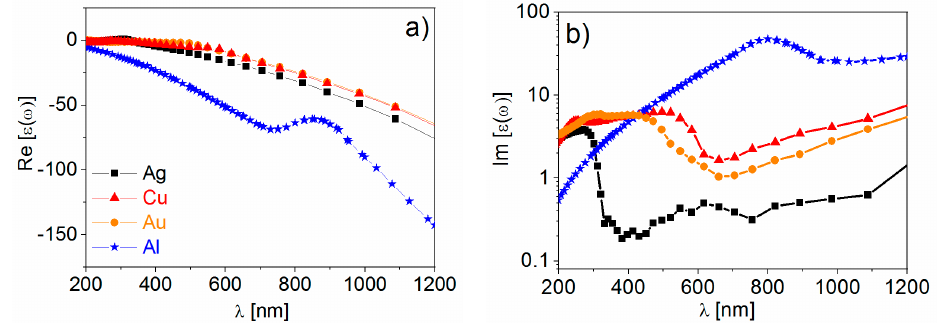
Figure 9. The real and imaginary part of the dielectric constant are reported in panel ( a , b ), respectively. The data for gold, silver, and copper are taken from Johnson et al. [162]; the data for aluminum are taken from Palik [163]. Reproduced with permission from Pilot et al. [81]. Copyright (2018), Springer International Publishing AG.